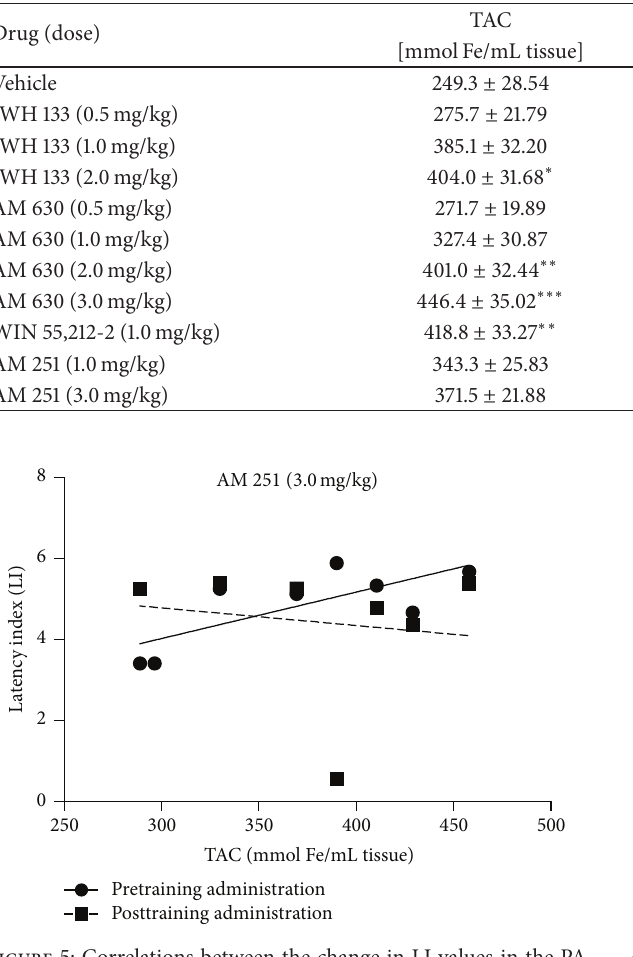
Figure 6: Correlations between the change in LI values in the PA test for the acquisition or consolidation of long-term memory and the concentration of SOD in the mice brain induced by the acute pretraining or posttraining injection of CB2 receptor antagonist AM 630 at the dose of 3.0